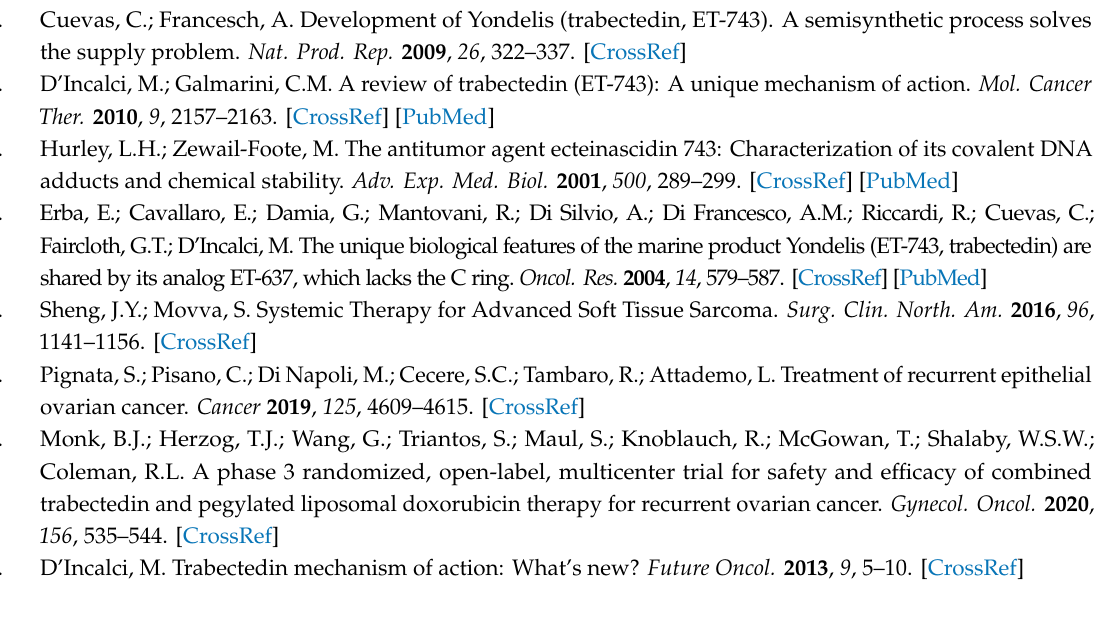
Figure S1: Treatment of hMFs with TRB and LUR attenuates zymosan-dependent phagocytosis, Figure S2: Treatment of hMFs with TRB promotes a time-dependent dephosphorylation of RNA pol II, Figure S3: Dose-dependent e ff ect of ROS production after the treatment of hMF-R and hTAM-R with TRB and LUR attenuates, Figure S4: Uncropped Western Blot